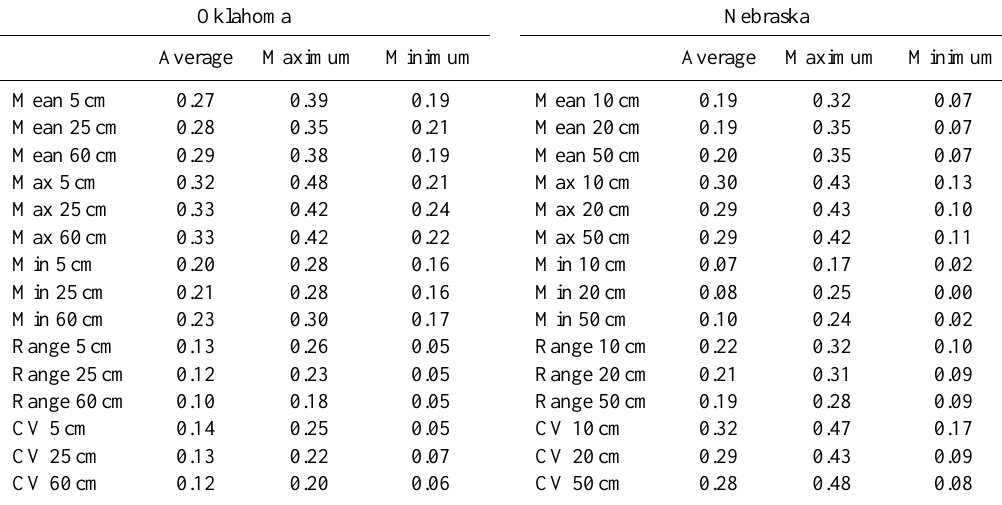
Table 2. Descriptive statistics for Oklahoma and Nebraska soil moisture. Table shows the mean, maximum, minimum, range and coefficient of variation (CV) averaged over all sites. All values are volumetric soil water content (cm 3 cm − 3 ) units.